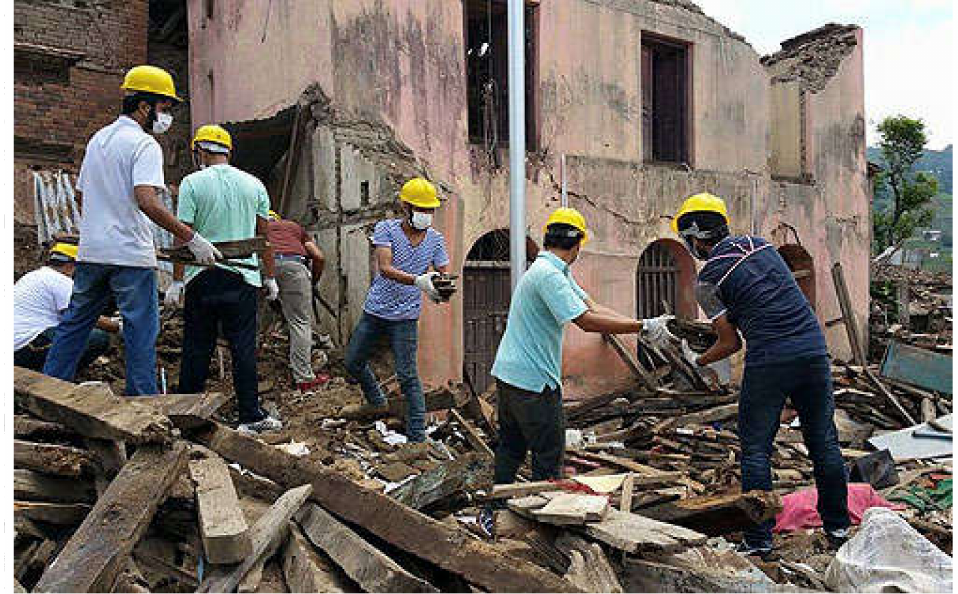
Figure 3. Operations of salvage of the mural painting fragments at Shantipur guided by the International Centre for the Study of the Preservation and Restoration of Cultural Property (ICCROM) experts and other international partners in the aftermath of the earthquake in Nepal,